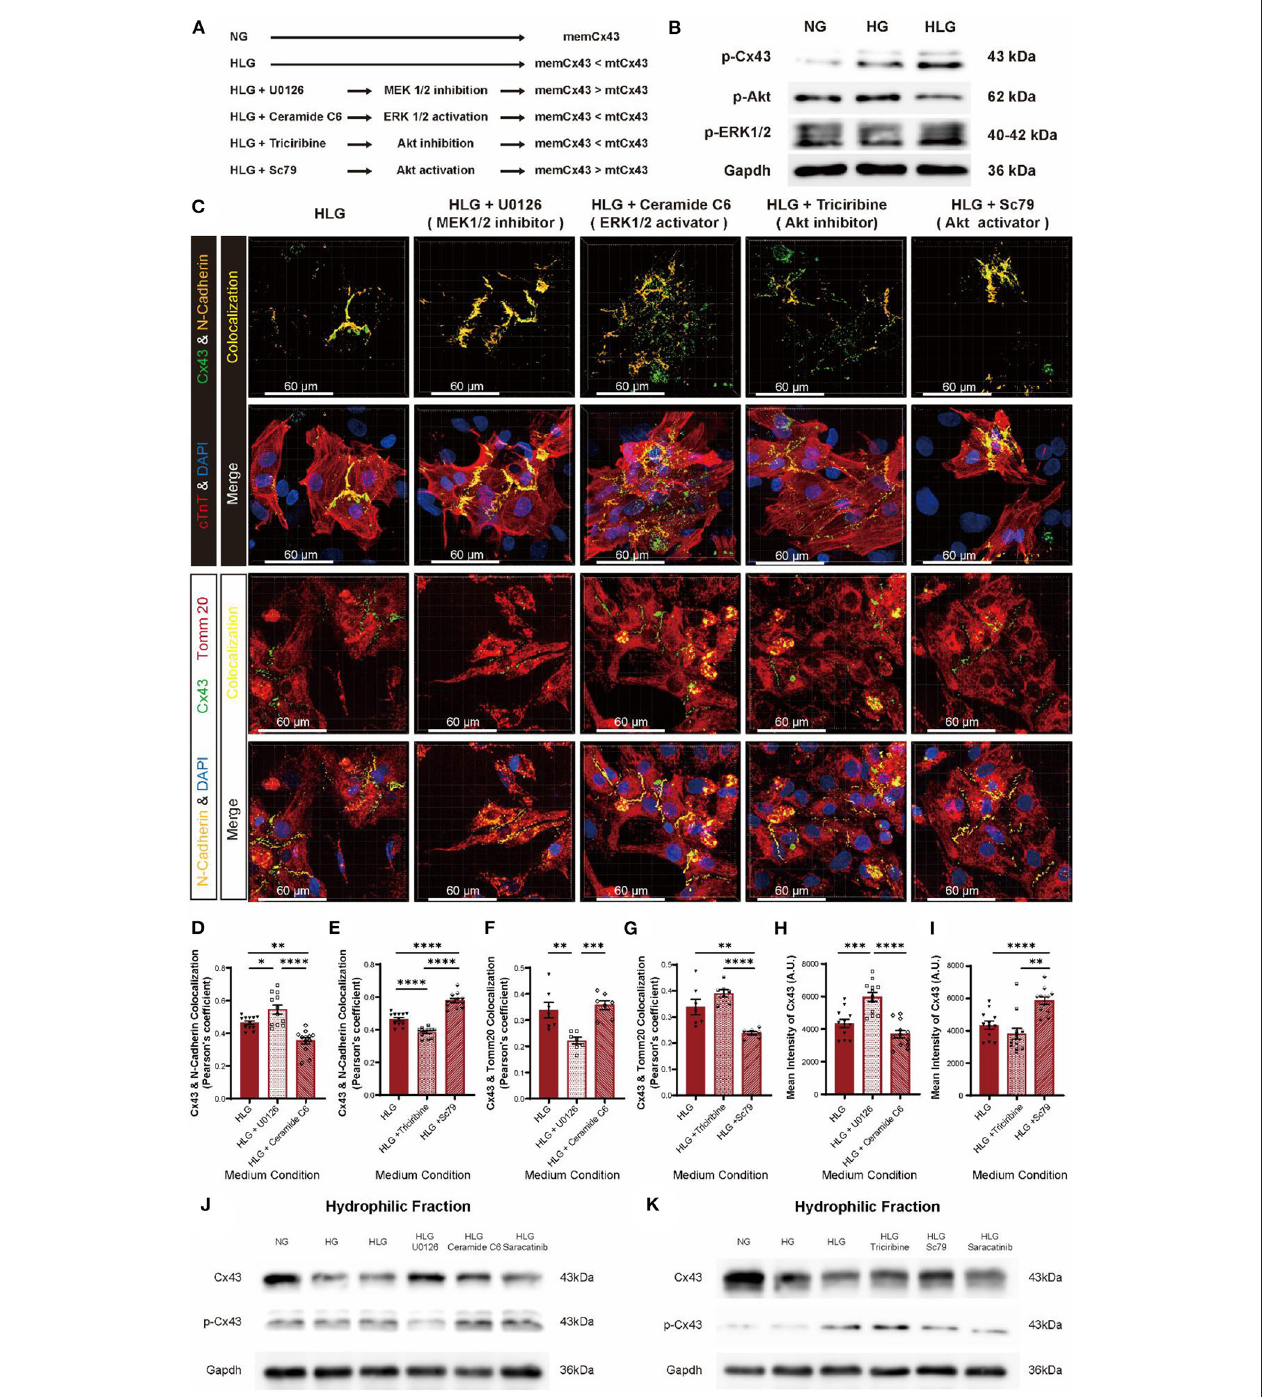
FIGURE 7 | MEK/ERK and PI3K/Akt pathways regulate Cx43 transfer into mitochondria through Src. (A) Schematic diagram of proposed abnormal Cx43 aggregation in mitochondria mechanism. (B) Phosphorylation of Cx43, Akt, and ERK1/2 under HLG condition. (C) Immunofluorescent staining of Cx43 of the HLG group under drug stimulation (scale bars, 60 µ m). (D–I) Analysis of colocalization of Cx43 and N-cadherin [ (D,E ), n = 12 field views per condition], Cx43 and Tomm20 [ (F,G) , n = 7 field views per condition], and mean intensity of Cx43 [ (H,I) , n = 12 field views per condition]. (J,K) Western blot of Cx43 and p-Cx43 in hydrophilic cell membrane of HLG with activators or inhibitors cultured NMVMs. Data are shown as mean ± SEM. One-way ANOVA test was used. * P < 0.05, ** P < 0.01, *** P < 0.001, **** P < 0.0001.